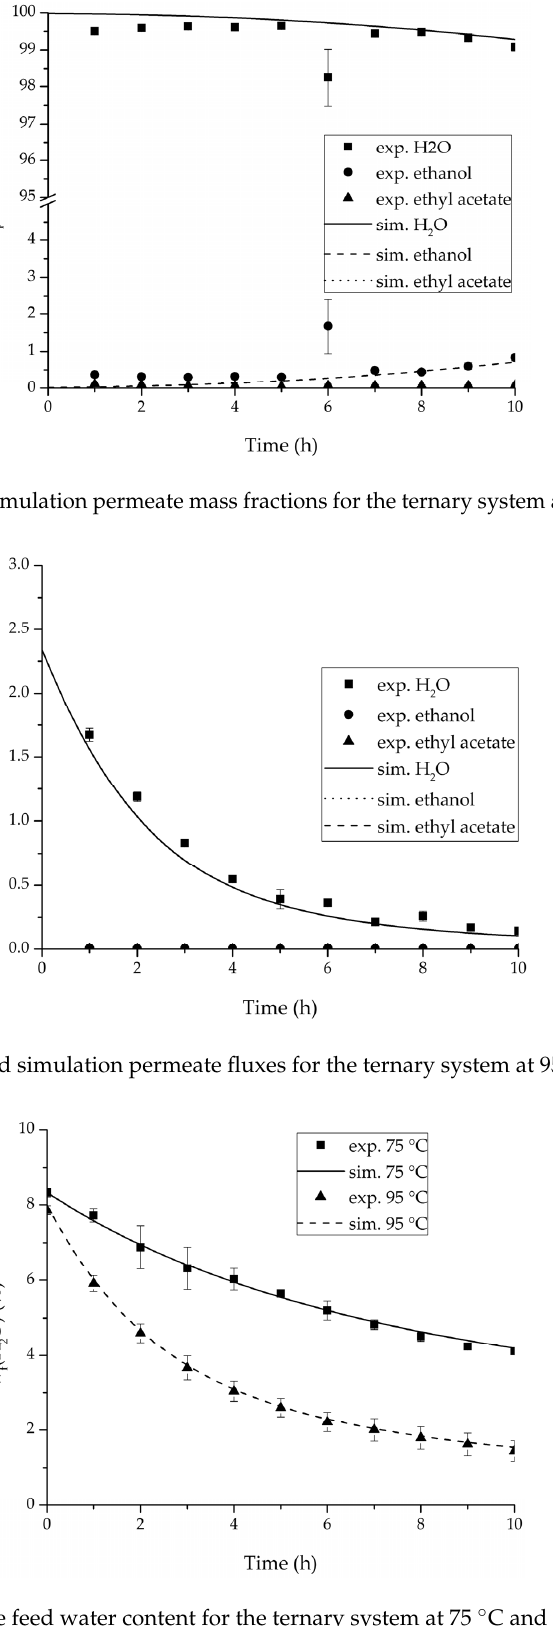
Figure 17. Comparison of the feed water content for the ternary system at 75 ◦ C and 95 ◦ C feed temperature.